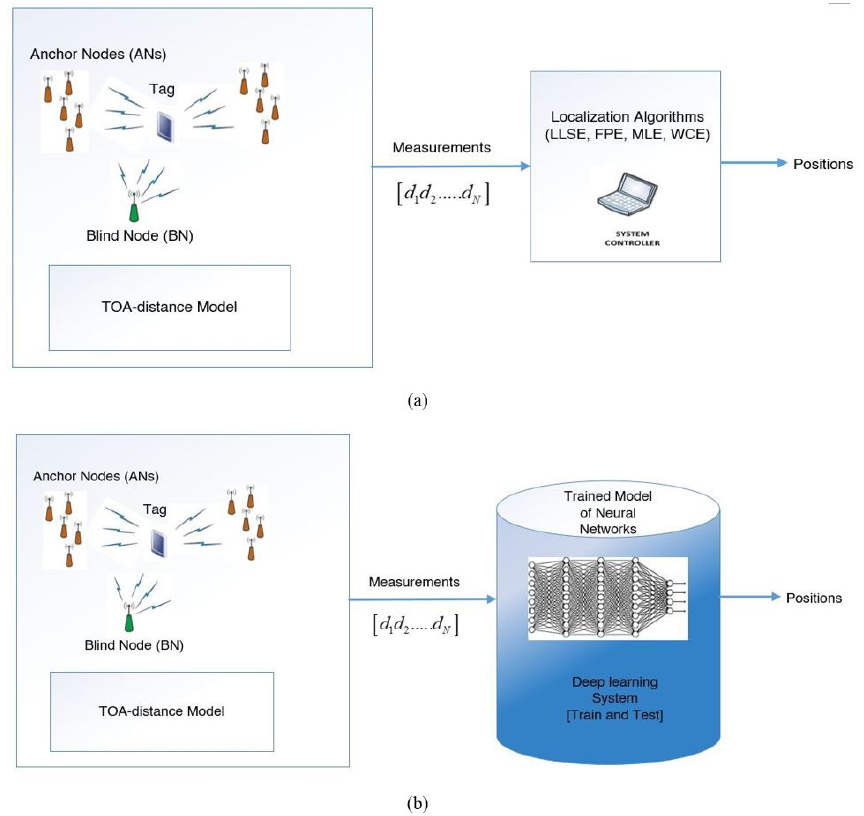
Figure 1. Ultra-wideband (UWB) localization systems. ( a ) Conventional UWB localization system. ( b ) Proposed UWB localization system using deep